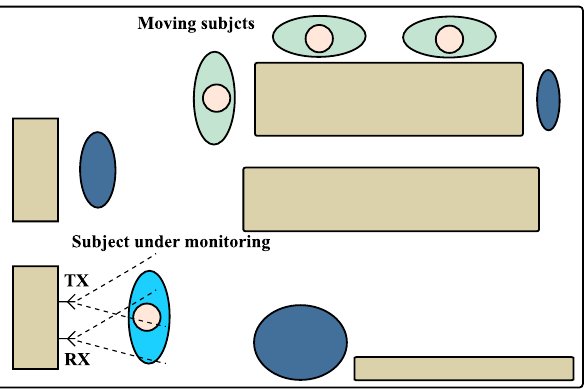
Figure 12. Schematics of the monitoring scenario used for the experiment.